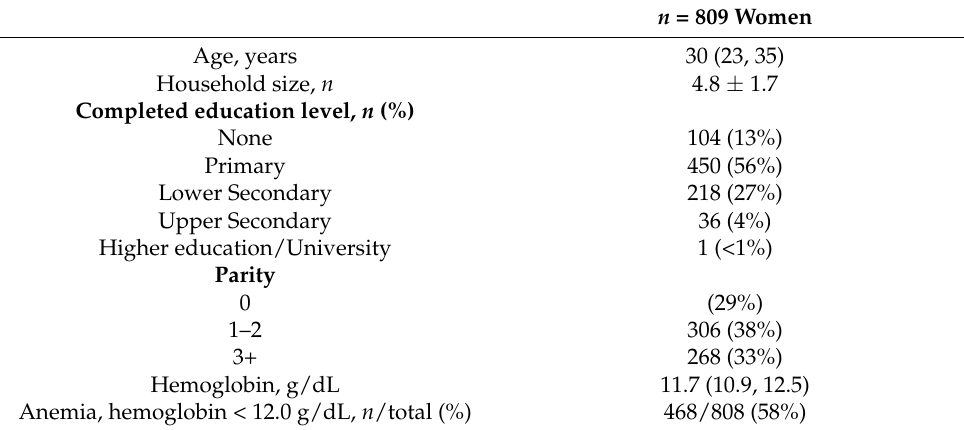
Table 1. Characteristics of all enrolled Cambodian women (18–45